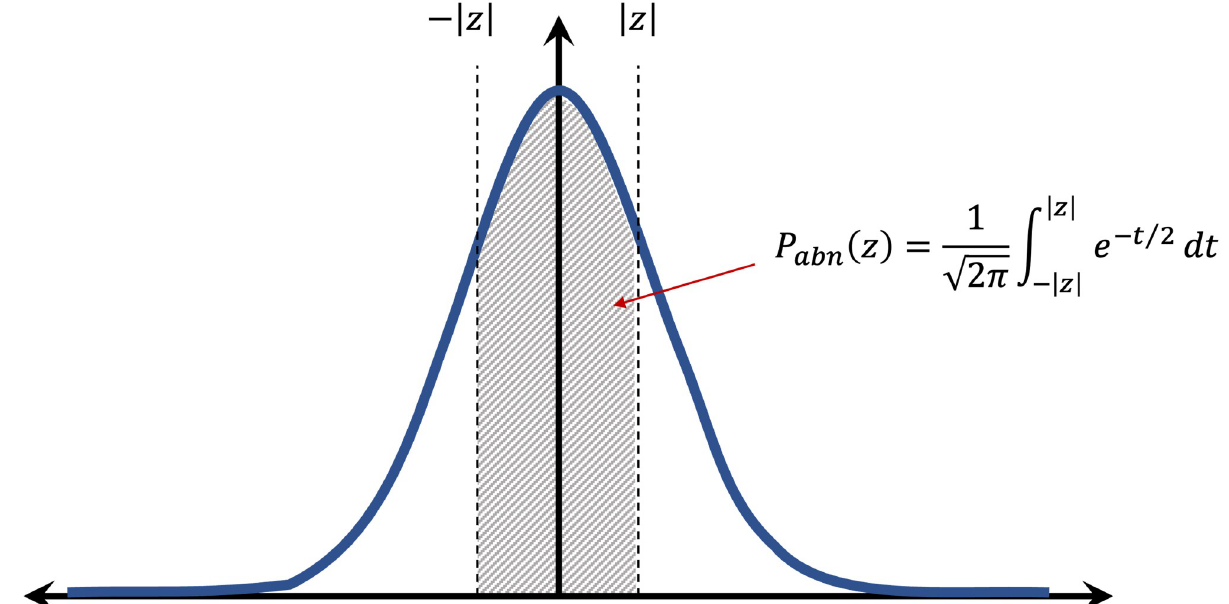
Fig 4. The area of the shaded region is computed as the abnormal probability index P population). The P abn is zero for a sample with 0 deviation from the norm and is getting closer to 1 as | z |